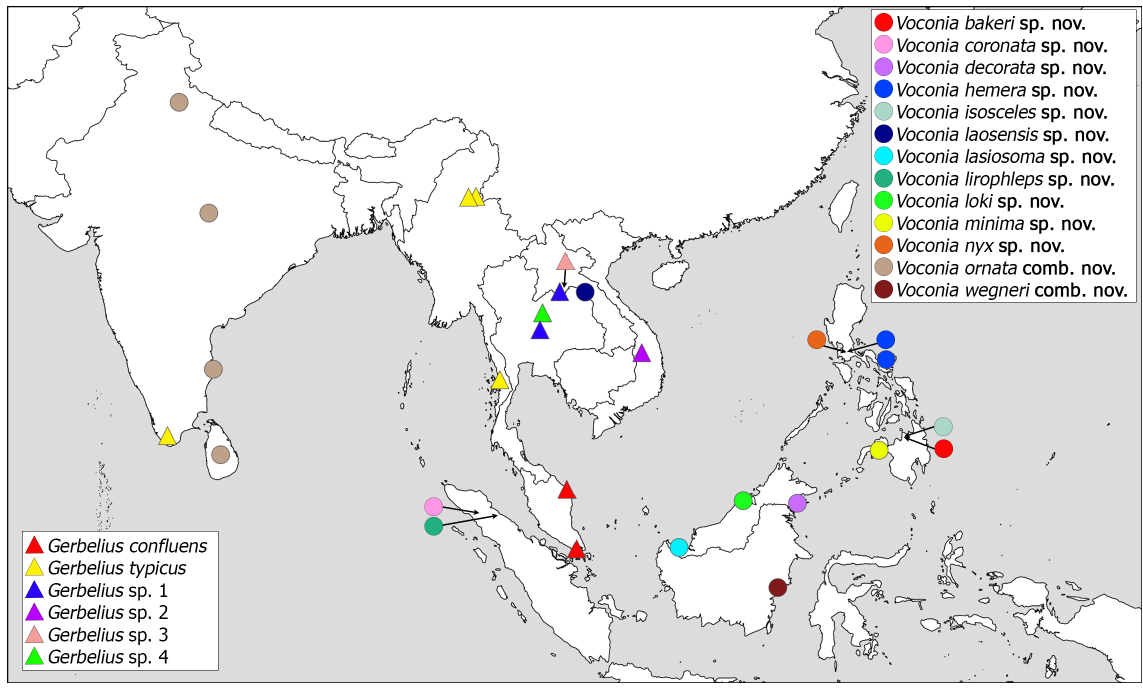
Fig. 20. The distribution of species of Gerbelius Distant, 1903 and Voconia Stål, 1866 in Southeast